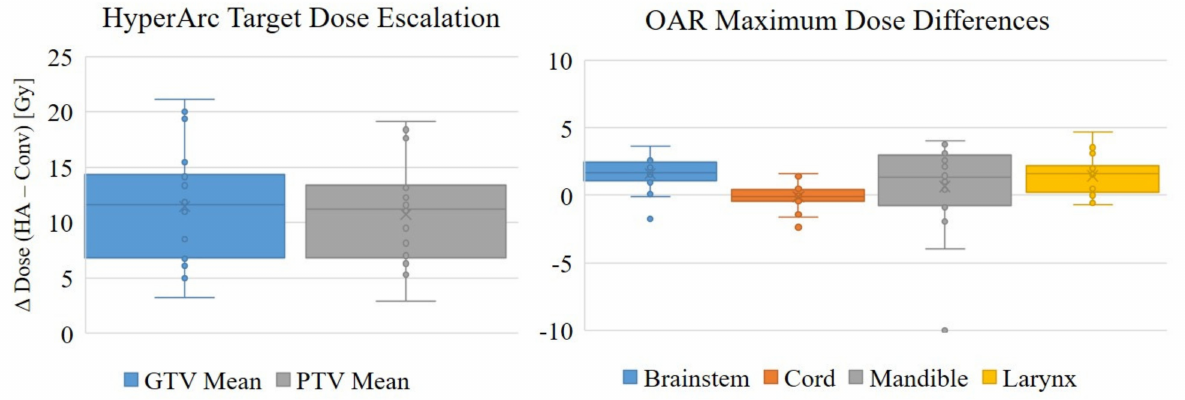
Figure 3. Target dose escalation and maximum OAR dose comparisons, plotted as the difference between the HyperArc (D HA ) and conventional (D Conv ) plan doses, in